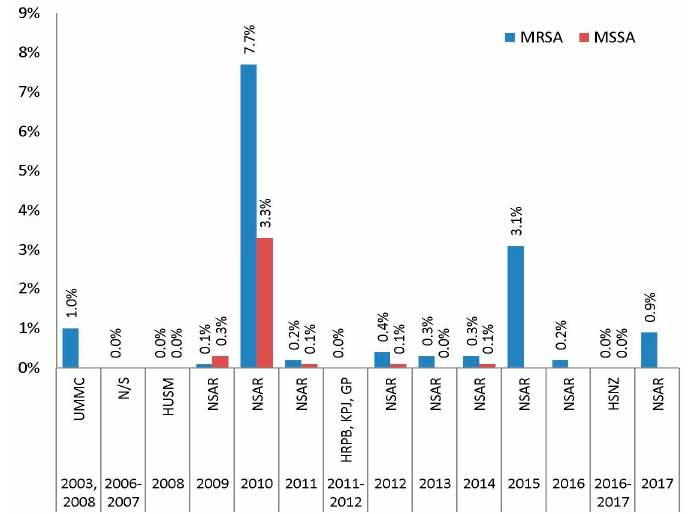
Figure 10. The prevalence of linezolid resistance in Malaysian S. aureus isolates, 2003–2017. Data from the NSAR; UMMC in 2003 and 2008 [18]; not specified (N / S) between 2006 and 2007 [17]; HUSM in 2008 [19]; HRPB, KPJ and GP between 2011 and 2012 [21]; and HSNZ in 2016 and 2017 [23].